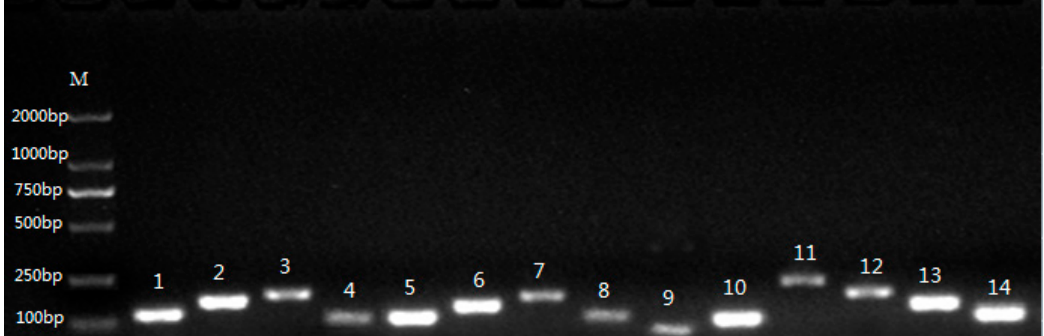
Figure 1. PCR products of 14 reference genes. M, DNA marker; 1, ACT7; 2, ACT101; 3, TUA; 4, TUB; 5, CYP; 6, 60S rRNA; 7, UBQ; 8, E3; 9, GAPDH1; 10, GAPDH2; 11, PP2A; 12, BAM3; 13, SAMDC; 14, ABC.